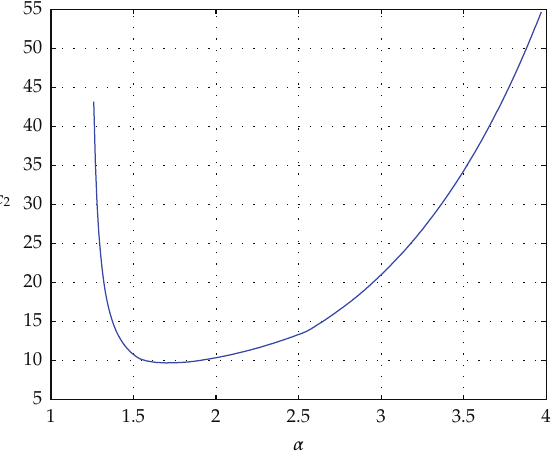
Figure 2: The local optimal bound of c 2